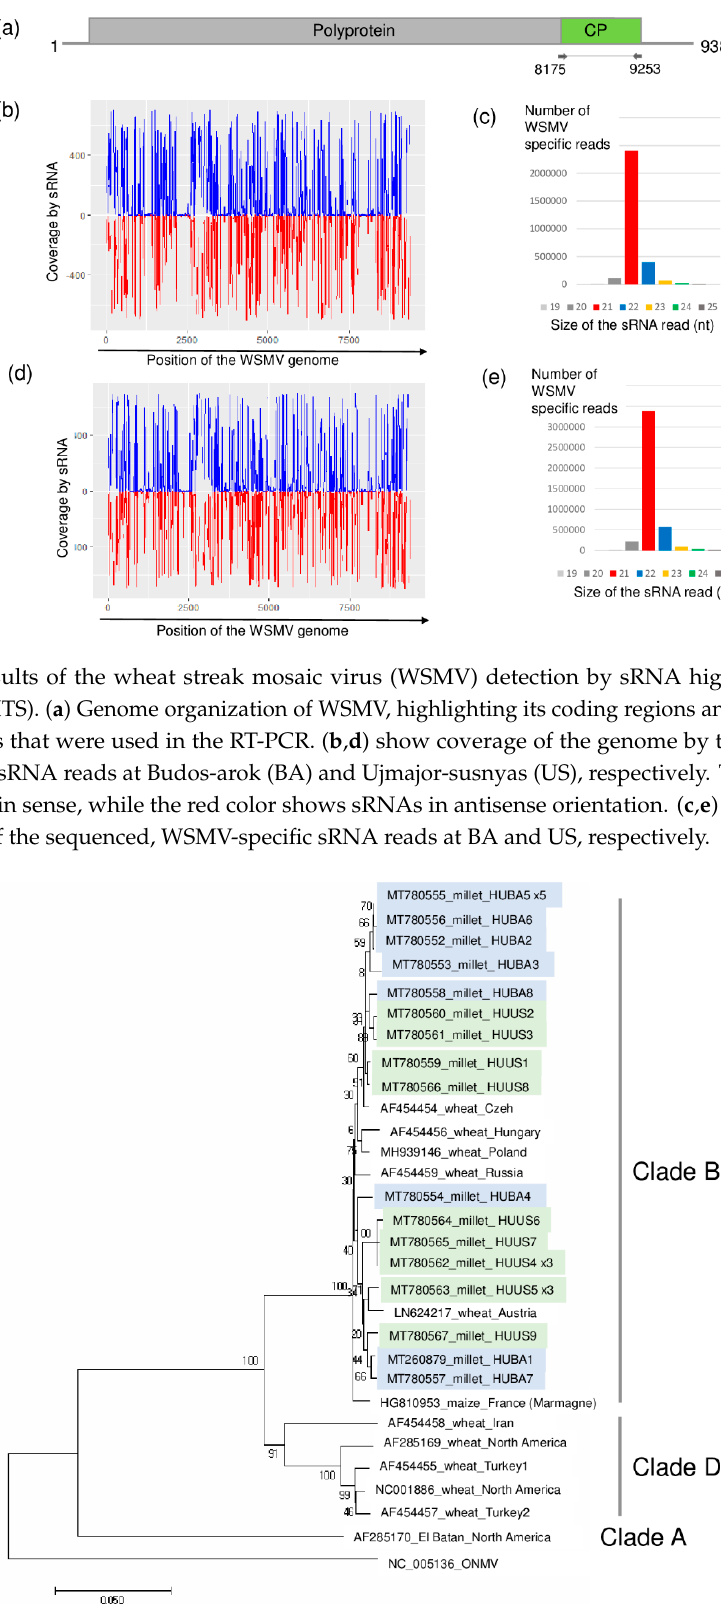
Figure 2. Phylogenetical analysis of the wheat streak mosaic virus strains originated from BA and US. (ONMV—Oat necrotic mottle virus). (ONMV—Oat necrotic mottle